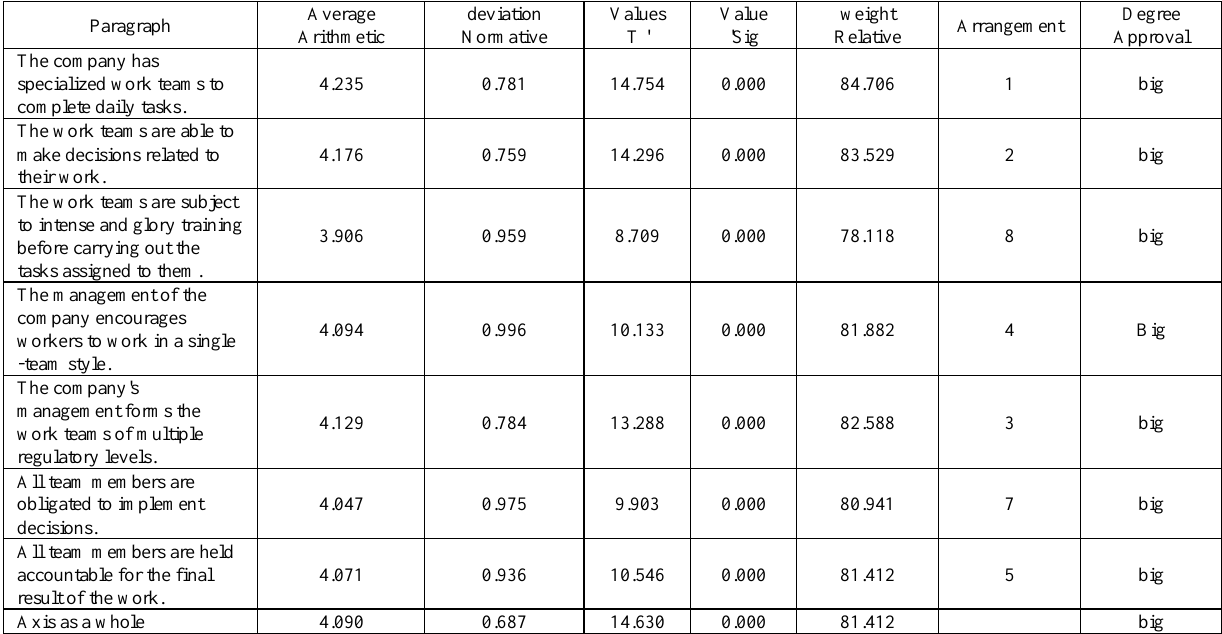
Table 15. Analysis of the axis of the team's